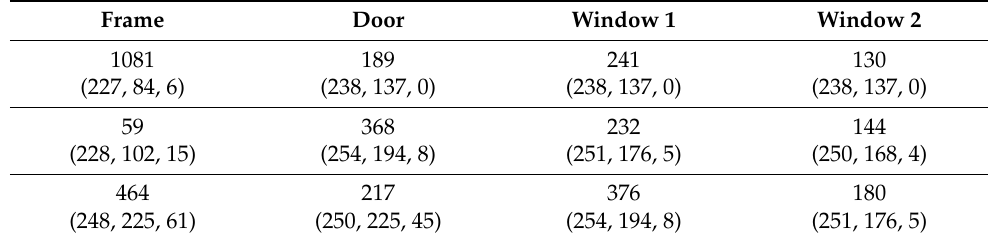
Table 2. Color distribution of façade and windows in IR